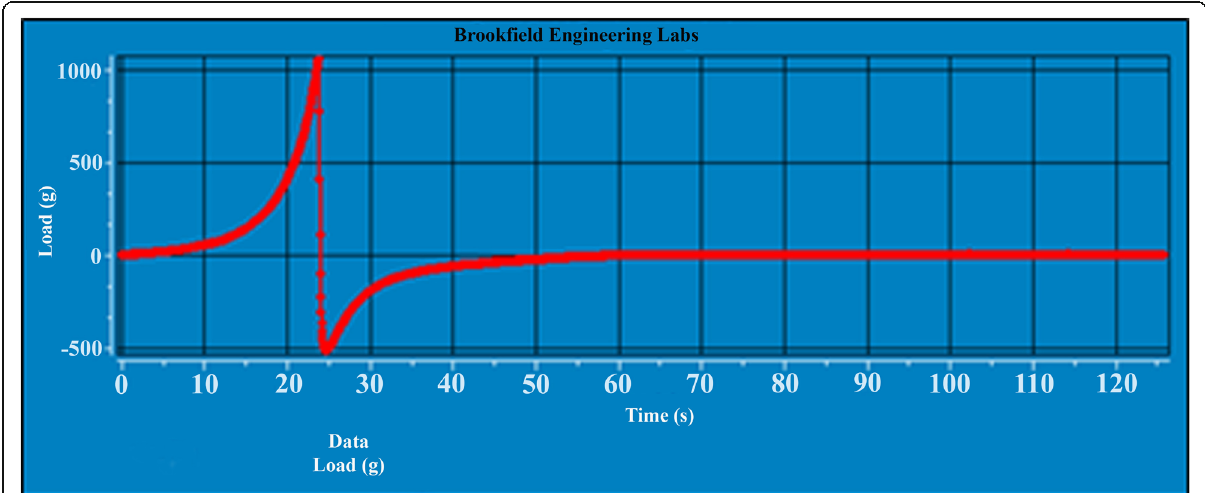
Fig. 5 Texture characterization graph for microemulsion containing sunscreen cream